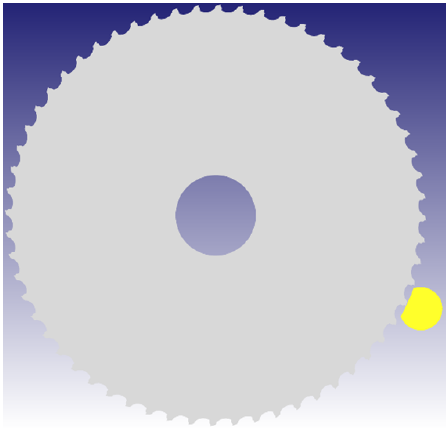
Figure 6. Relative position of saw blade and workpiece in simulation.